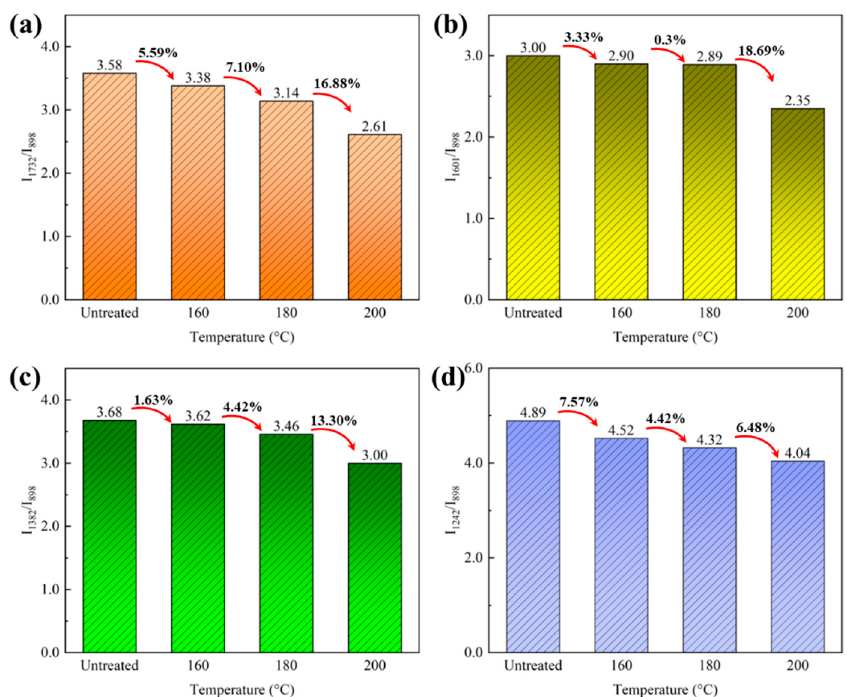
Figure 2. Relative intensity of characteristic peaks of the untreated and treated bamboo: (a) I 1732/898 , (b) I 1601/898 , (c) I 1382/898 , and (d) I 1242/898 . ( b ) I 1601/898 , ( c ) I 1382/898 , and ( d ) I 1242/898